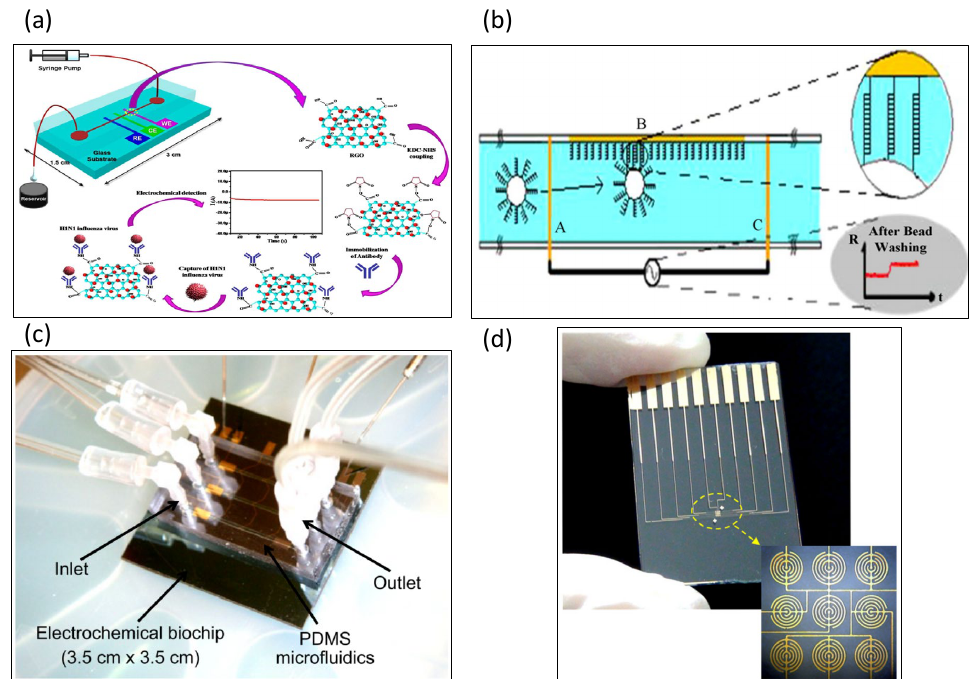
Figure 8. Glass-based impedance biosensors for detecting other organisms and chemicals. ( a ) An electrical impedance sensing chip was developed to detect influenza H1N1 virus. Reproduced with permission from [115]. Copyright Scientific Reports 2017. ( b ) Impedance sensors were developed for DNA hybridization. Reproduced with permission from [117]. Copyright Sensors and Actuators B: Chemical 2011. ( c ) Single-stranded DNA probes were functionalized onto electrodes. Complementary DNA hybridization was then induced using electrochemical impedance spectroscopy. Reproduced with permission from [118]. Copyright Biosensors and Bioelectronics 2012. ( d ) Galectin-1 protein is a biomarker of bladder cancer. An impedance immunosensor was developed to detect